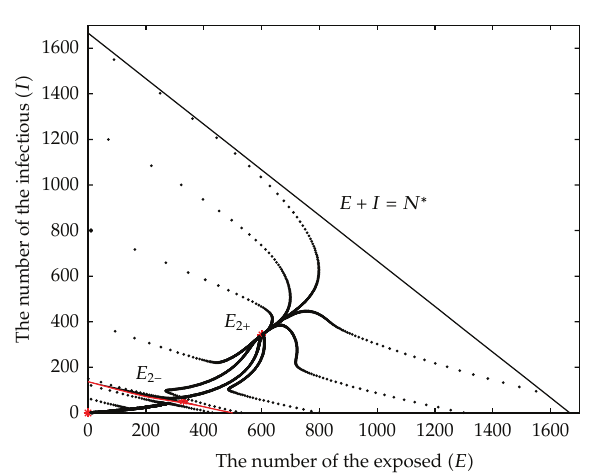
Figure 3: The attraction separatrix for those two equilibria of model (cid:2) 3.1 (cid:3)